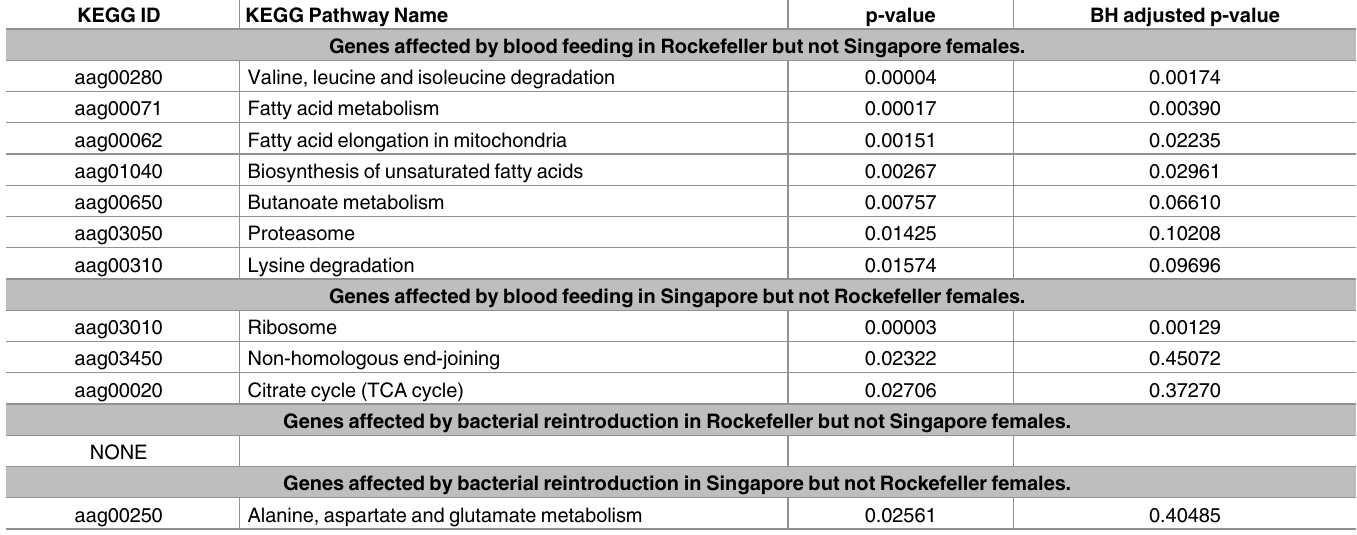
Table 3. KEGG pathways enriched among genes showing changes in transcript abundance in either Rock or Sing in response to blood feeding or bacterial reintroduction. KEGG